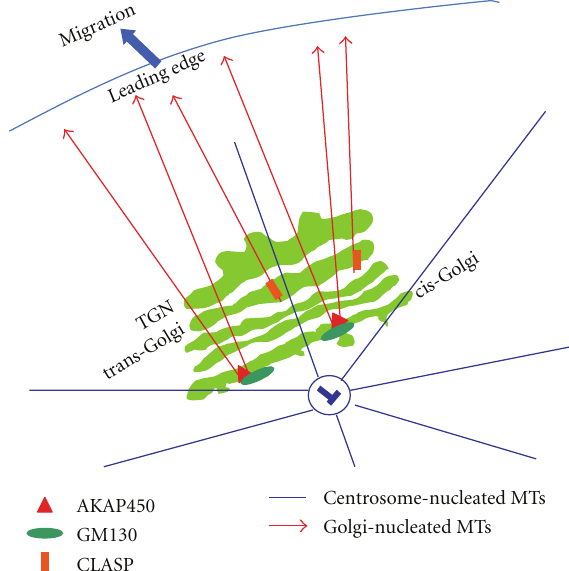
Figure 1: Schematic illustration of the Golgi in a migrating cell. The Golgi is oriented towards the leading edge and the microtubules (MTs) that nucleate from the Golgi are also oriented towards the leading edge (red), contrary to centrosomal MTs (blue) that are